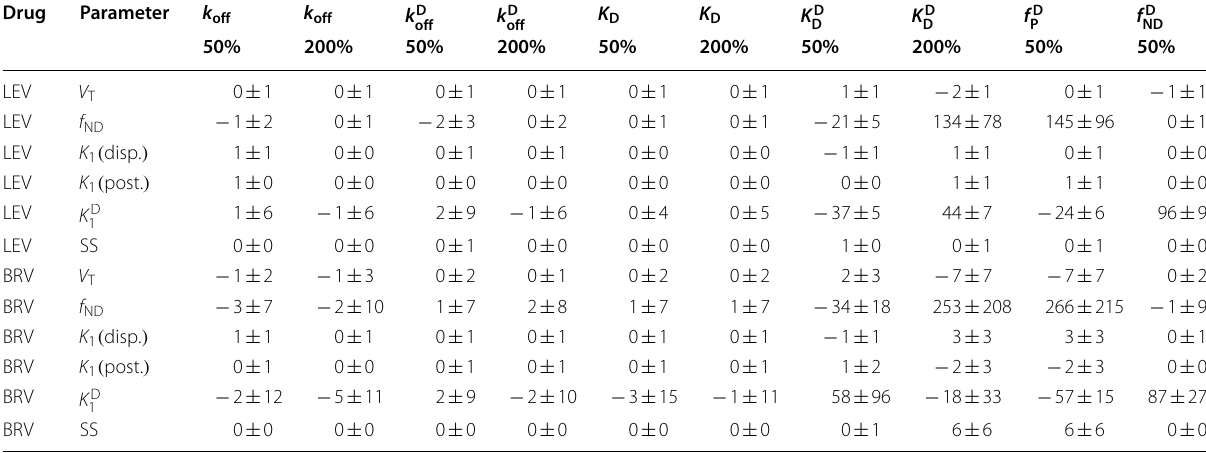
Data are mean and SD of percent change compared with the estimated parameter using the 5p model. A positive value means that the estimated parameter using the 5p model with either 50% or 200% of the fixed value is higher than that using the 5p model